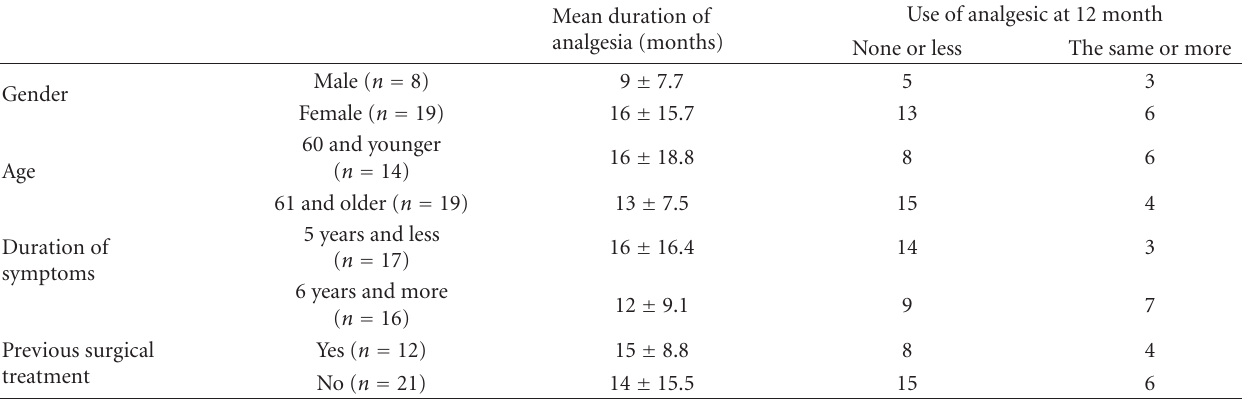
Table 1: Patients’ parameters and outcome of the